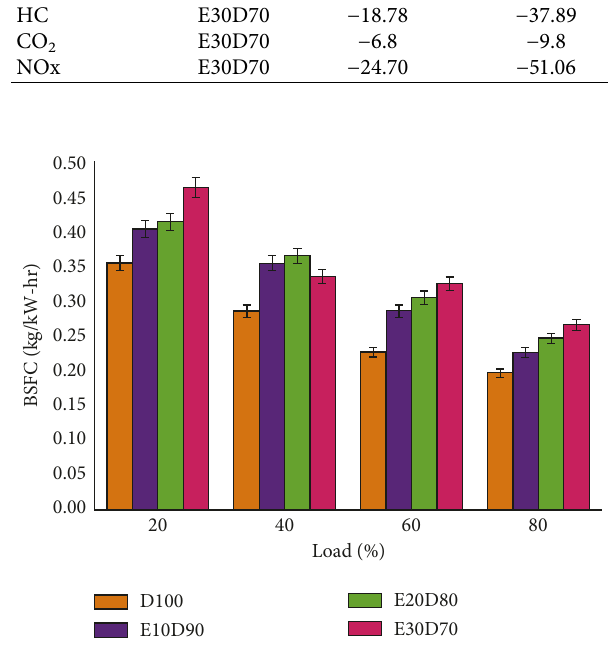
Figure 5: Variation in BSFC with